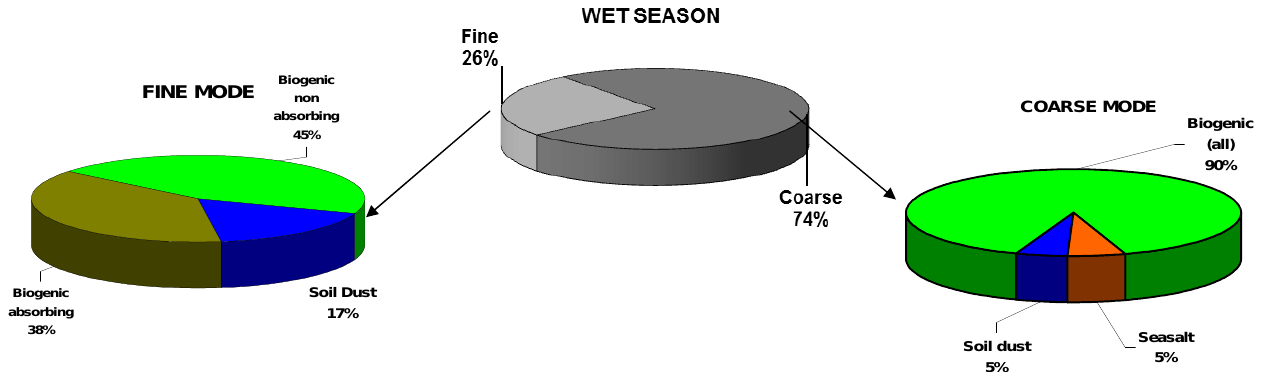
Fig. 9. Final result of Absolute Principal Component Analysis: fine/coarse mode partitioning of aerosol concentration during the 1st semester, and the individual contribution for each extracted principal component. The mean concentrations were 6.6 ± 2.9µgm − 3 for the coarse mode and 2.2 ± 1.3µgm − 3 for the fine mode.